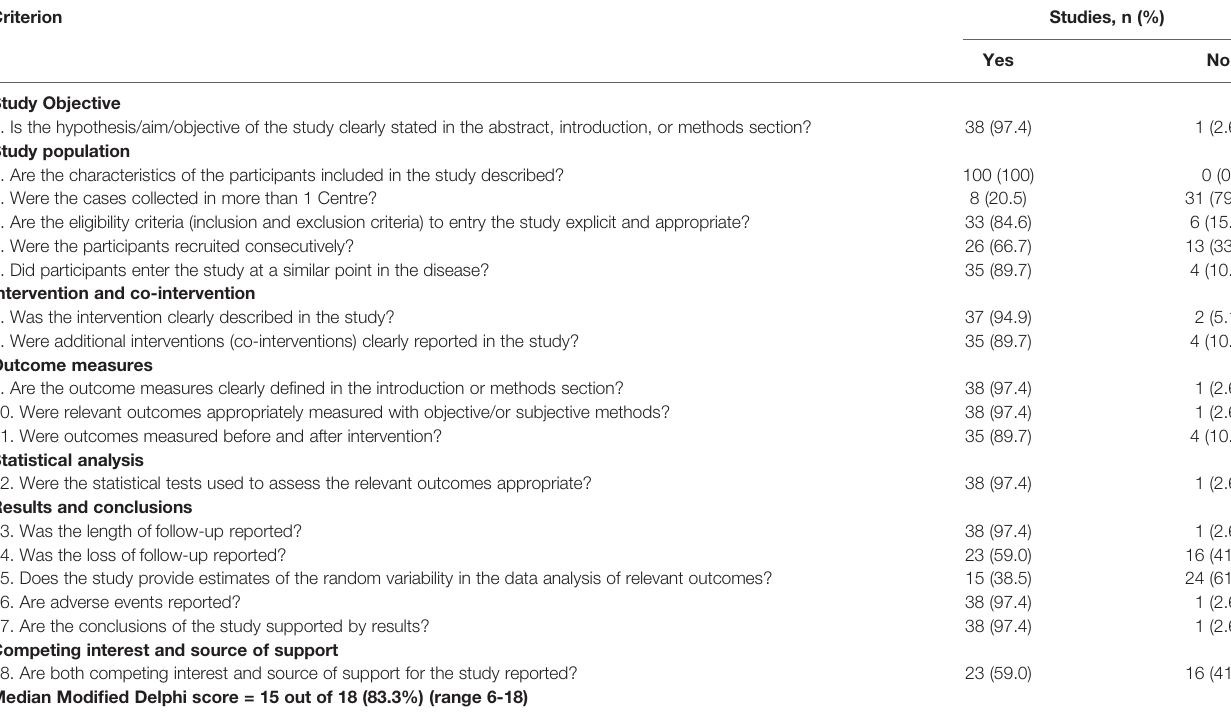
TABLE 1 | Summary fi ndings from the Modi fi ed Delphi checklist for quality assessment applied to all included studies (n=39).